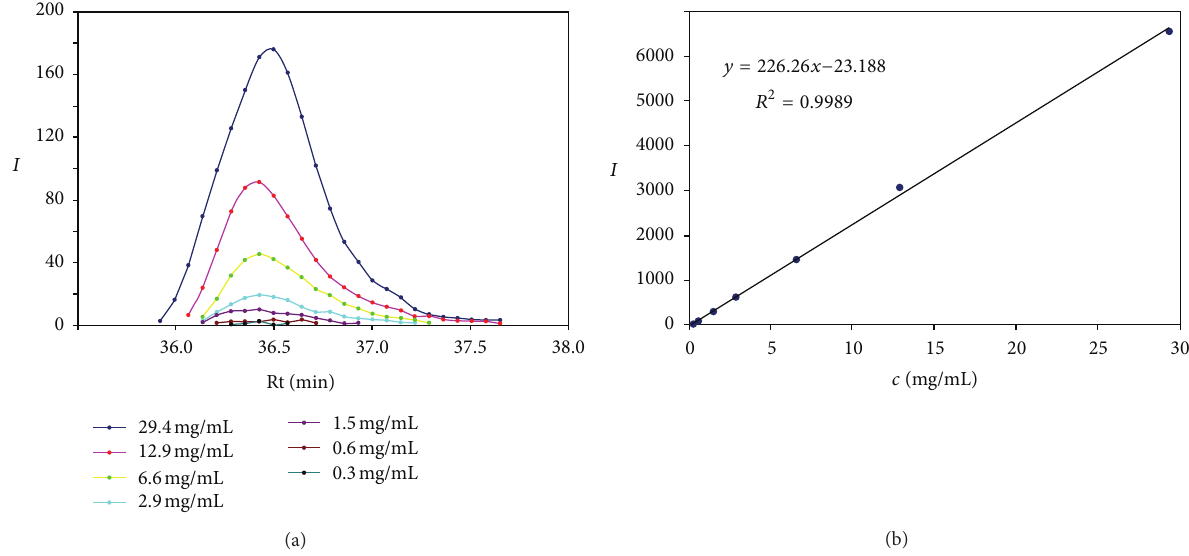
Figure 2: Calibration of the on-flow HPLC-NMR experiment. “ 𝐼 ” on the y -axis stands for integral in the individual 1 H NMR spectra (a) or overall integral obtained by numerical integration (b).